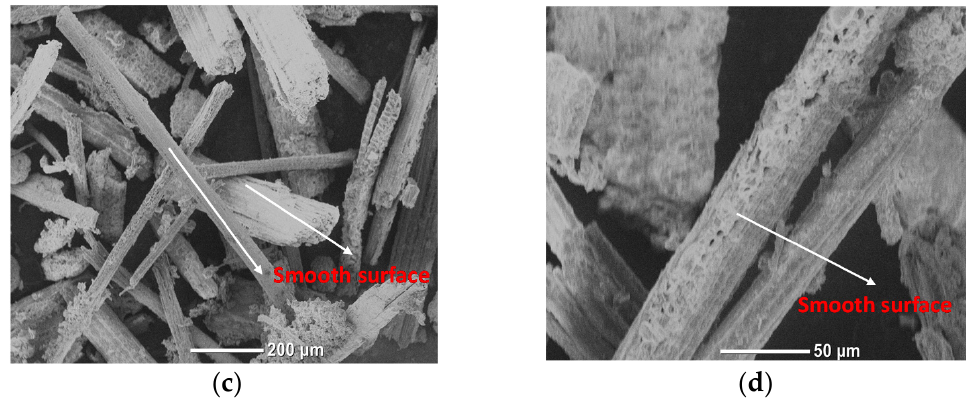
Figure 2. SEM of ( a , b ) UTDPWF, and ( c , d ) NaOH treated fibers.